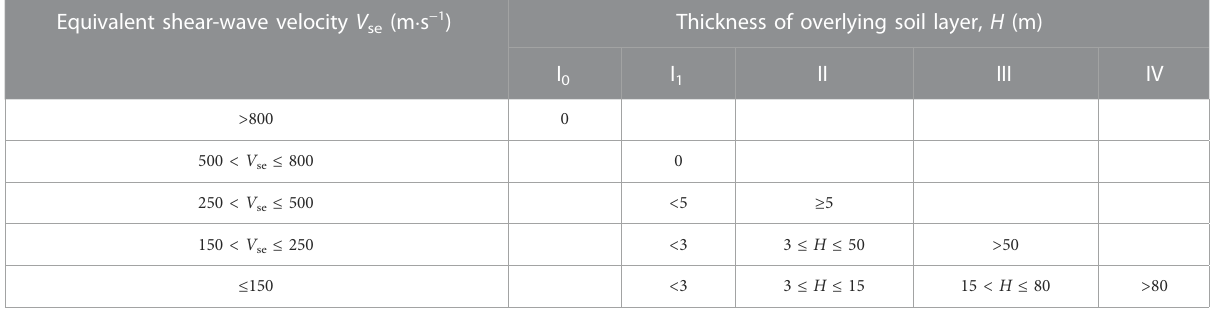
TABLE 1 Site categories de fi ned by the Code for Seismic Design of Buildings of China (GB 50011, 2010). Equivalent shear-wave velocity V se (m · s − 1 )